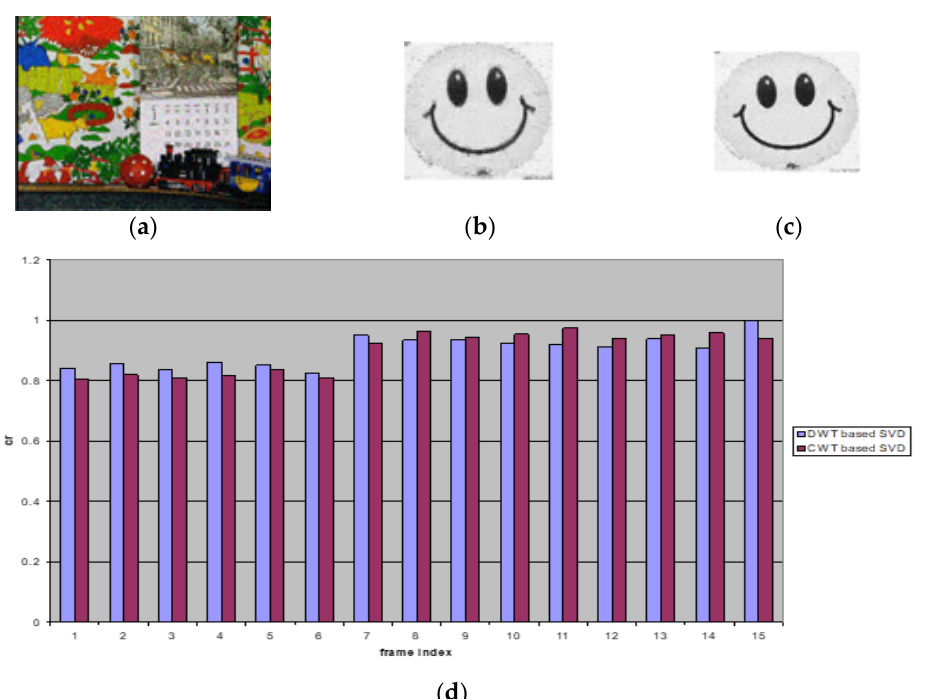
Figure 11. ( a ) The watermarked frame under Gaussian noise attack using the proposed method. ( b ) Extracted watermark from frame 10 of the first video scene in the proposed method. ( c ) Extracted watermark from frame 10 of the first video scene in the DWT-based SVD method. ( d ) Correlation values for the extracted watermarks for frames 1 to 15 in the first video scene under Gaussian attack.